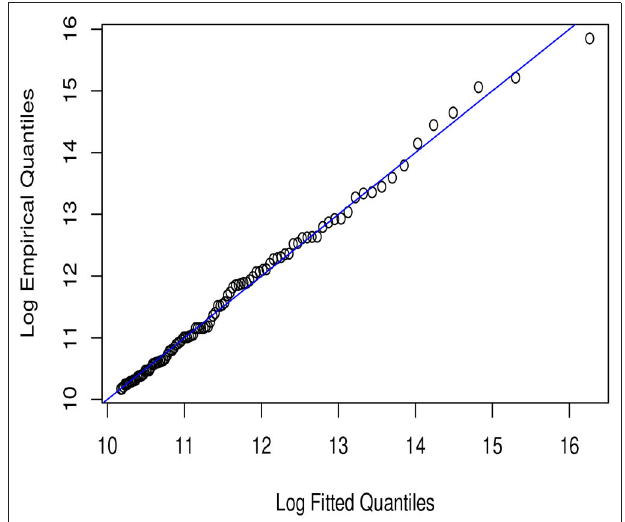
FIGURE 5 | Paralogistic